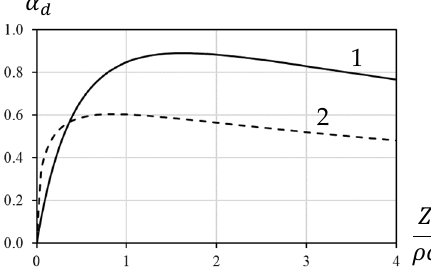
Figure 7. The diffuse absorption coefficients of the surfaces with normal (1) and tangential (2) im- pedances.